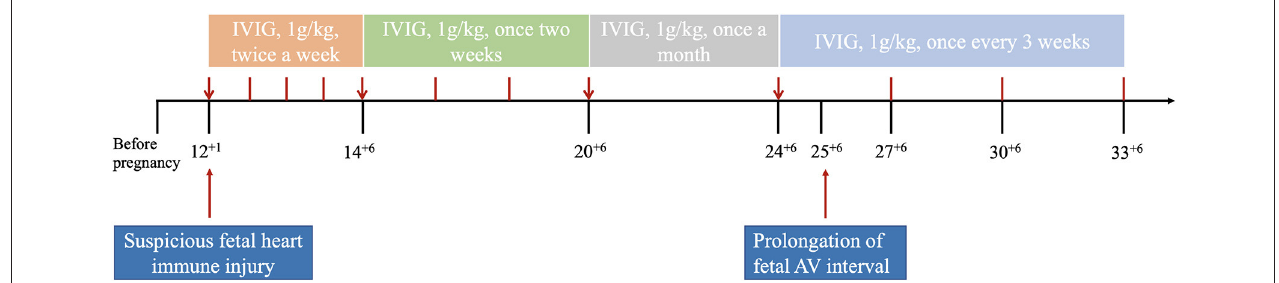
FIGURE 1 | The patient was treated with methylprednisolone (8mg, once a day), hydroxychloroquine (200mg, twice a day), and tacrolimus (2mg, twice a day) throughout this pregnancy. And important events during pregnancy are indicated by long red arrow symbols. Adjustment time-point of IVIG are marked by short red arrows, and the frequency of usage are marked by red bars.